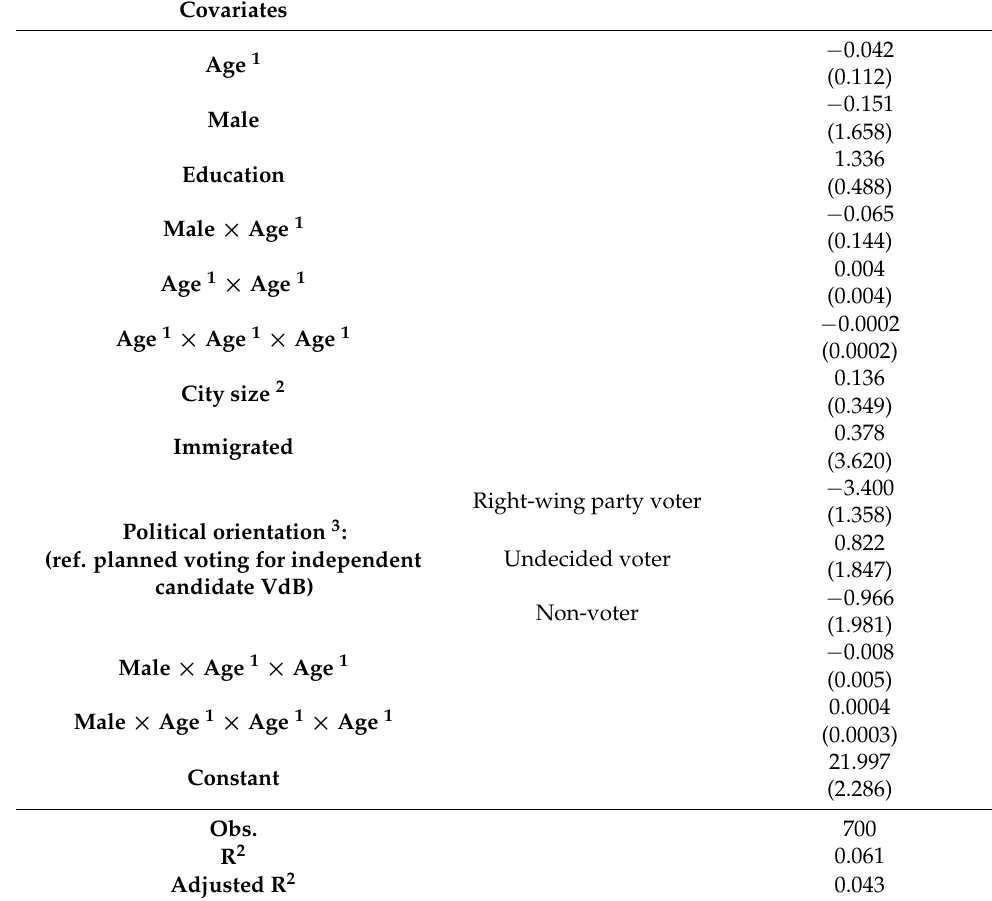
Table A3. Effect sizes of the multivariate regression model with cubic splines used to predict men’s and women’s SVO development shown in Figure 1’s